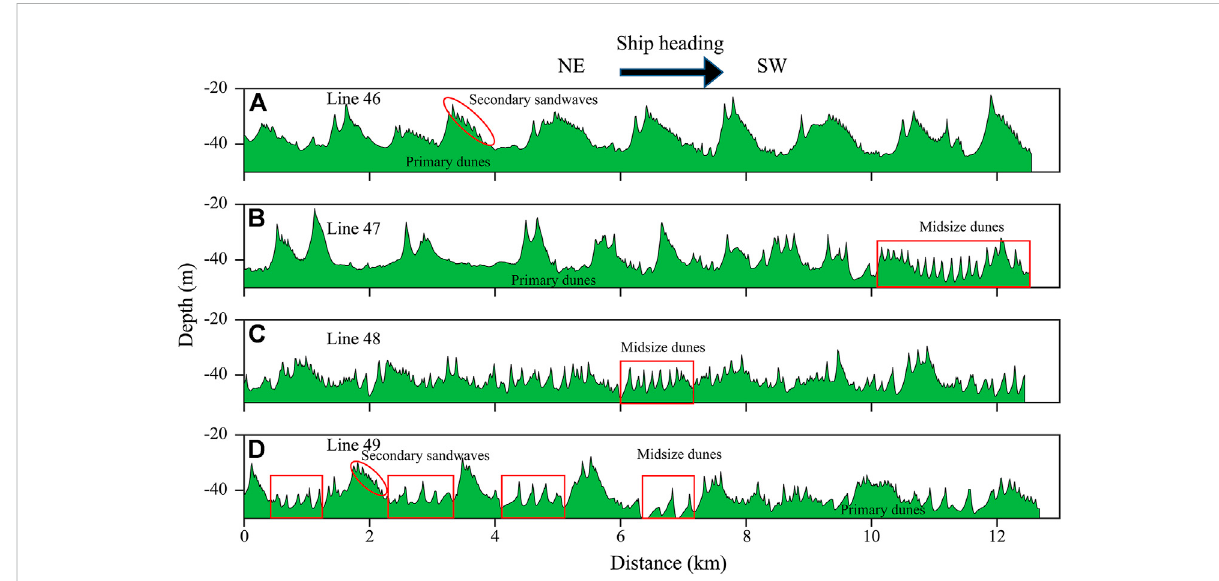
FIGURE 3 Themorphologicalpro fi leofsandwavesinLines46,47,48,and49. (A) Line46containsmainlytheprimary(giant)dunes,withsecondary(small) sandwaves riding on the stoss side of the primary. (B) Line 47 depicts the transition from primary to the midsize dunes that tend to reside in the troughs of the primary. (C) Line 48 is dominated by the midsize dunes such that primary dunes are hardly identi fi able. (D) Line 49 has the primary dunes returned but also clearly shows the midsize dunes in the troughs and the secondary sandwaves on the stoss side of the primary dunes.